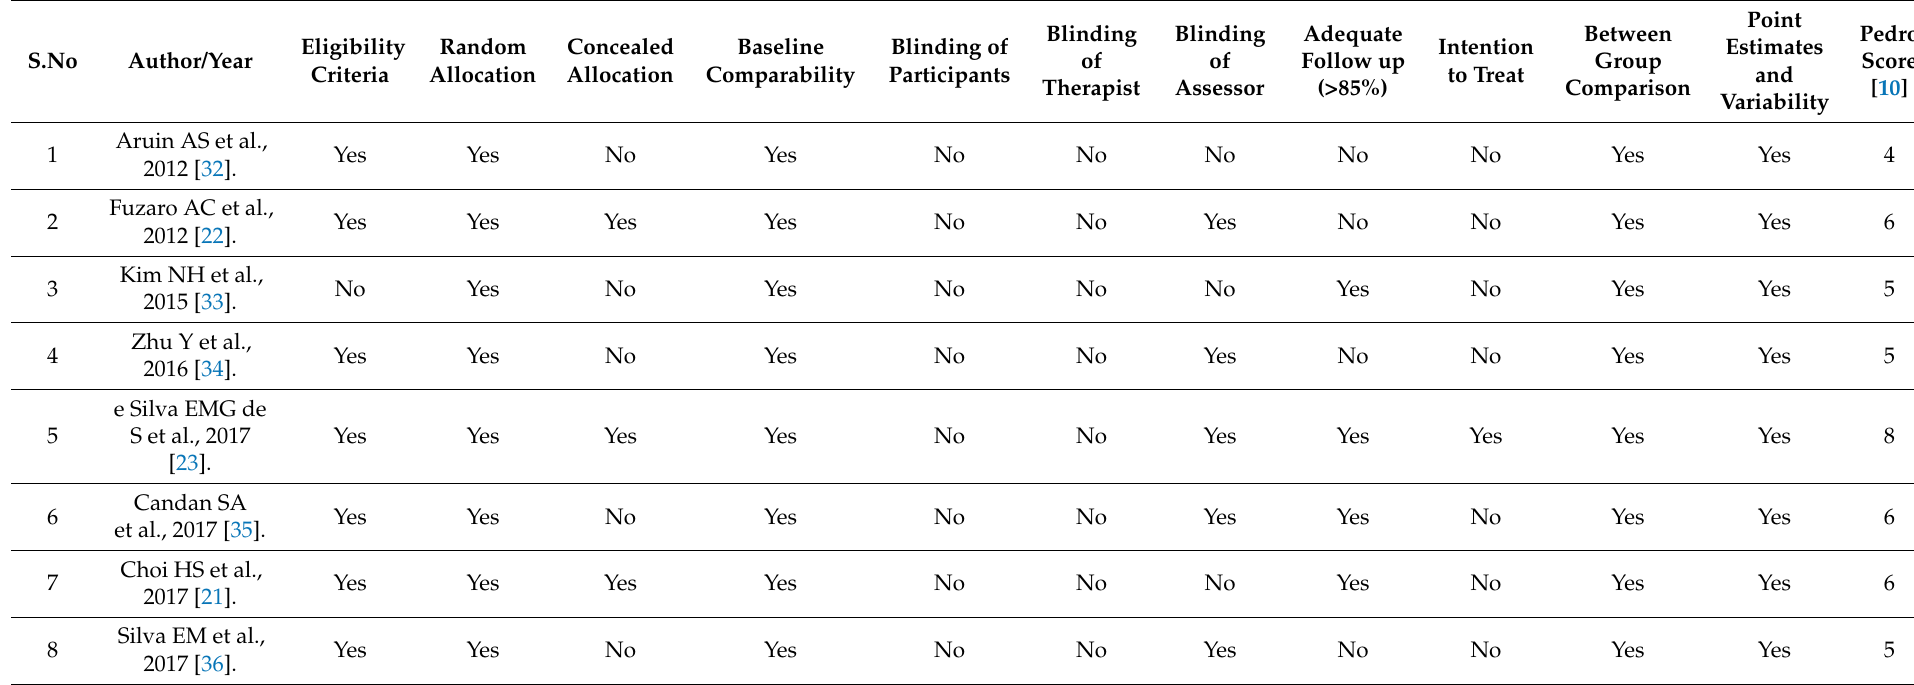
Table 2. Quality evaluation of involved RCT’s by PEDro